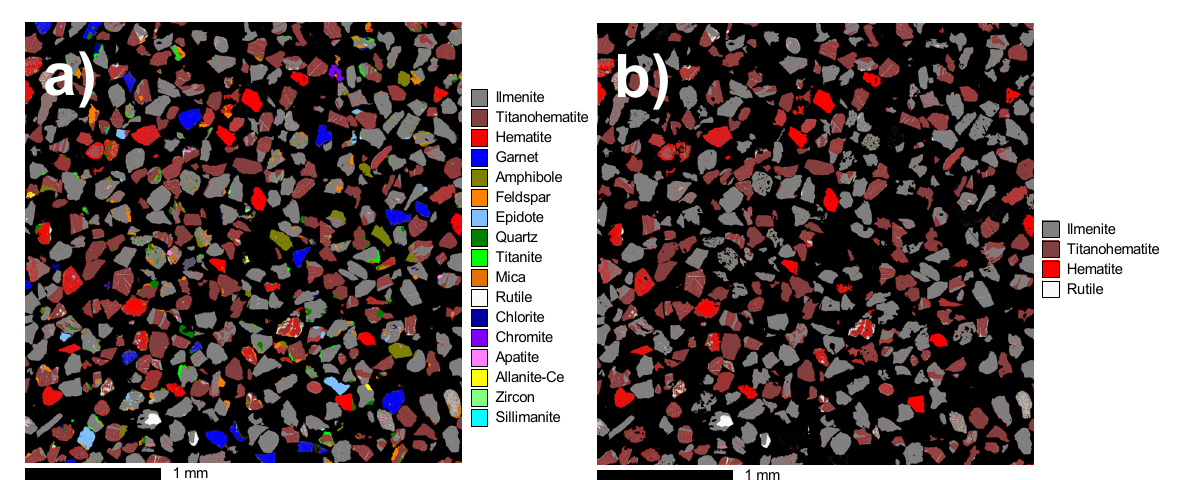
Figure 7. EPMA map results for the bulk ilmenite sample showing ( a ) the phase patched map with the distribution of all phases present in the sample and ( b ) a map with the distribution of Fe- and Fe-Ti oxide phases and rutile. Operating conditions for the microprobe during mapping were an accelerating voltage of 20 keV, a beam current of 80 nA, a step size of 2 µm (in x and y) and a counting time of 25 ms per step.